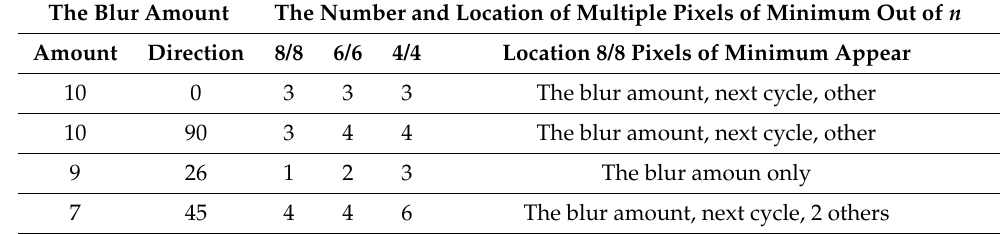
Table 15. The number of the pixels ( n / n ) and their locations where multiple pixels of minimum appeared out of sub-images out of area A and B ( n = 4, 6, 8). The Blur Amount The Number and Location of Multiple Pixels of Minimum Out of n Amount Direction